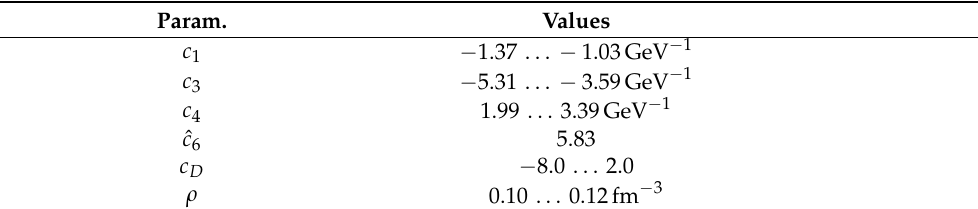
Table 1. Parameters fed into the WIMP scattering program.